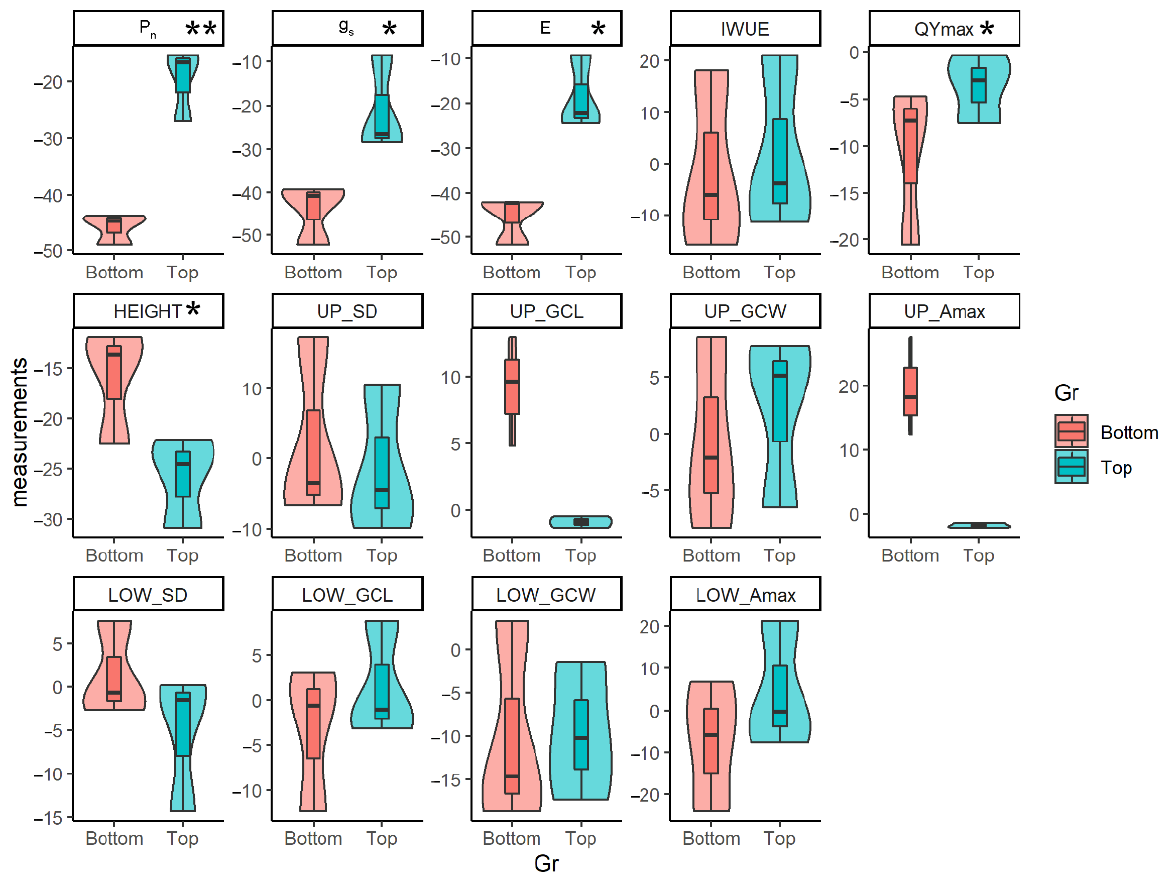
Figure 3. Violin plots of physiological and stomatal traits in drought stress plasticity between two groups of rice; the top (best-performing lines) and bottom (worst-performing lines) groups were represented in pink and blue, respectively ( p < 0 .05 ‘*’, p < 0 .01 ‘**’ ).